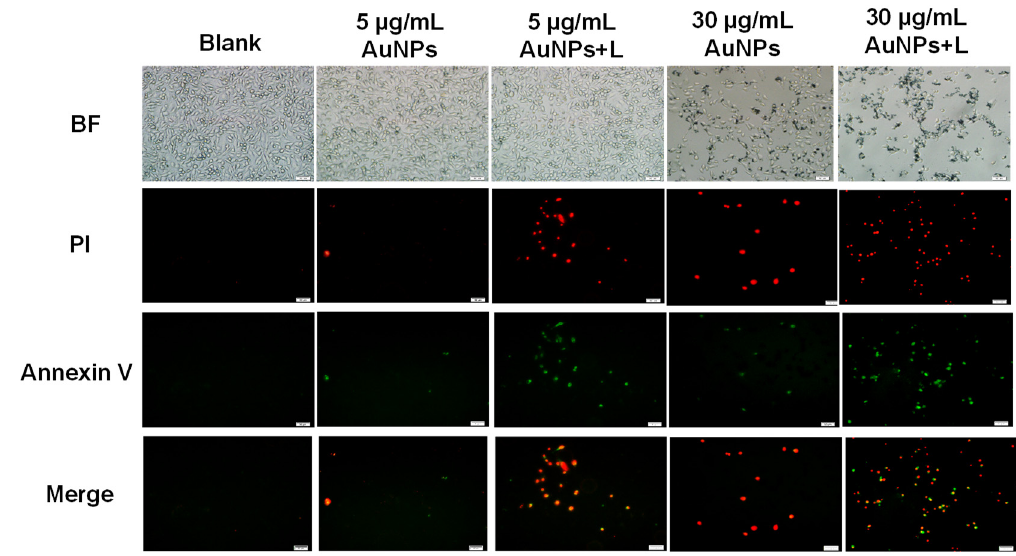
Figure 4. Apoptosis and necrosis in MDA-MB-231 cells upon exposure to HA-capped AuNPs (with/without NIR lighting) at different Au concentrations, according to an AnnexinV/PI double staining assay. Scale bar represents 50 μ m.